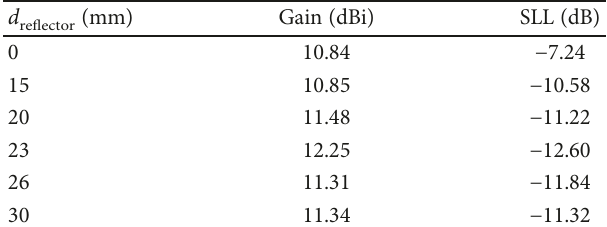
Table 2: Analysis of the re fl ector diameter of the omnidirectional ring-based SWAA.